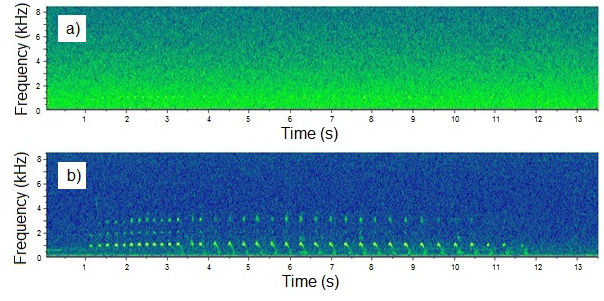
Fig. 7 . Spectrogram of a Pied-billed Grebe call made from an autonomous recording unit equipped with (1) a degraded microphone showing severe static and (2) a normally functioning microphone showing no static. Both recordings were recorded within the same triad and during the same broadcast trial. Accompanying recordings for these spectrograms are available in Appendices 6 and 7,